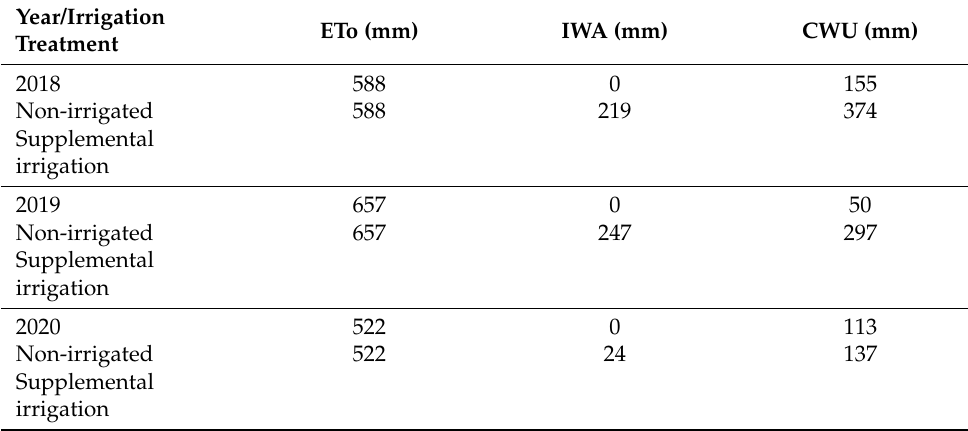
Table 1. Accumulated reference evapotranspiration (ETo), irrigation water applied (IWA), and crop water use (CWU) of ‘Roja Lisa’ cactus pear under non-irrigated and supplemental irrigation in 2018, 2019, and 2020. Data were collected from a commercial orchard, ‘Las 100 Hect á reas’. La Victoria, Pinos, Zacatecas, Mexico.